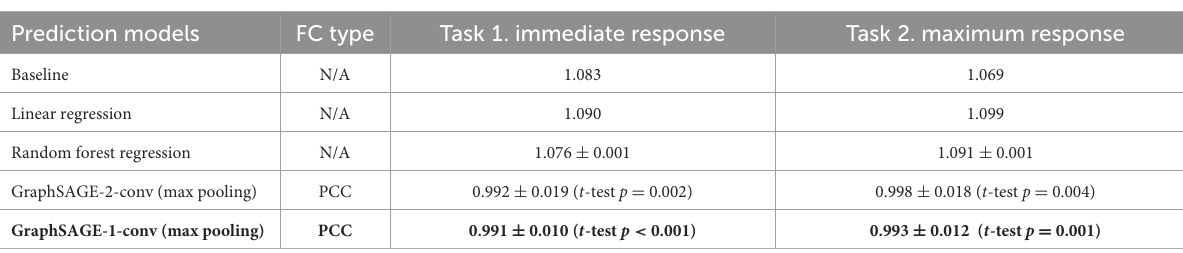
TABLE 1 Performance comparison (average